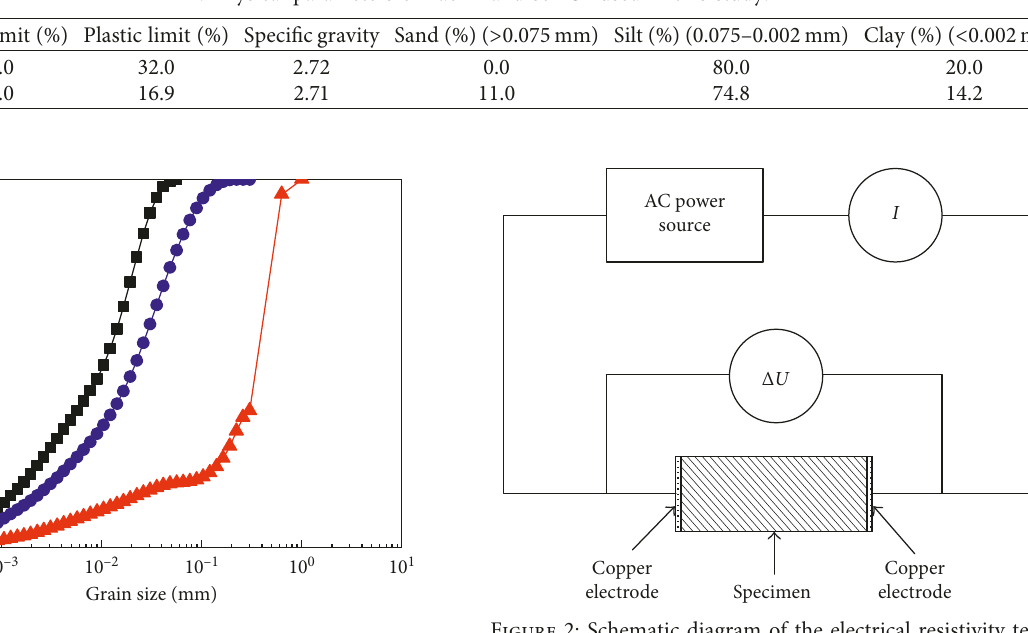
Figure 2: Schematic diagram of the electrical resistivity